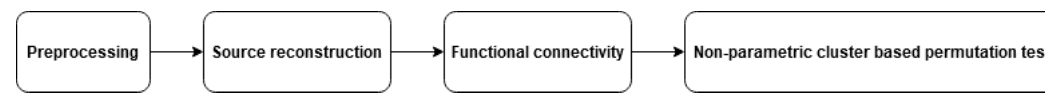
Figure 2. Pipeline illustrating the steps performed during the data analysis.